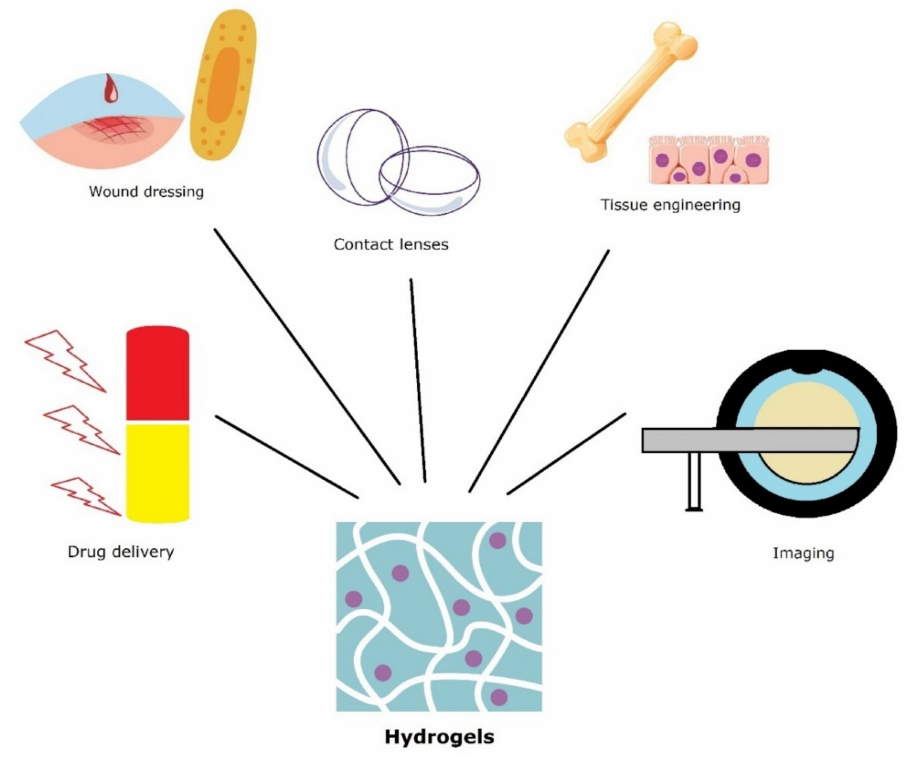
Figure 6. Various applications of hydrogel mesoporous